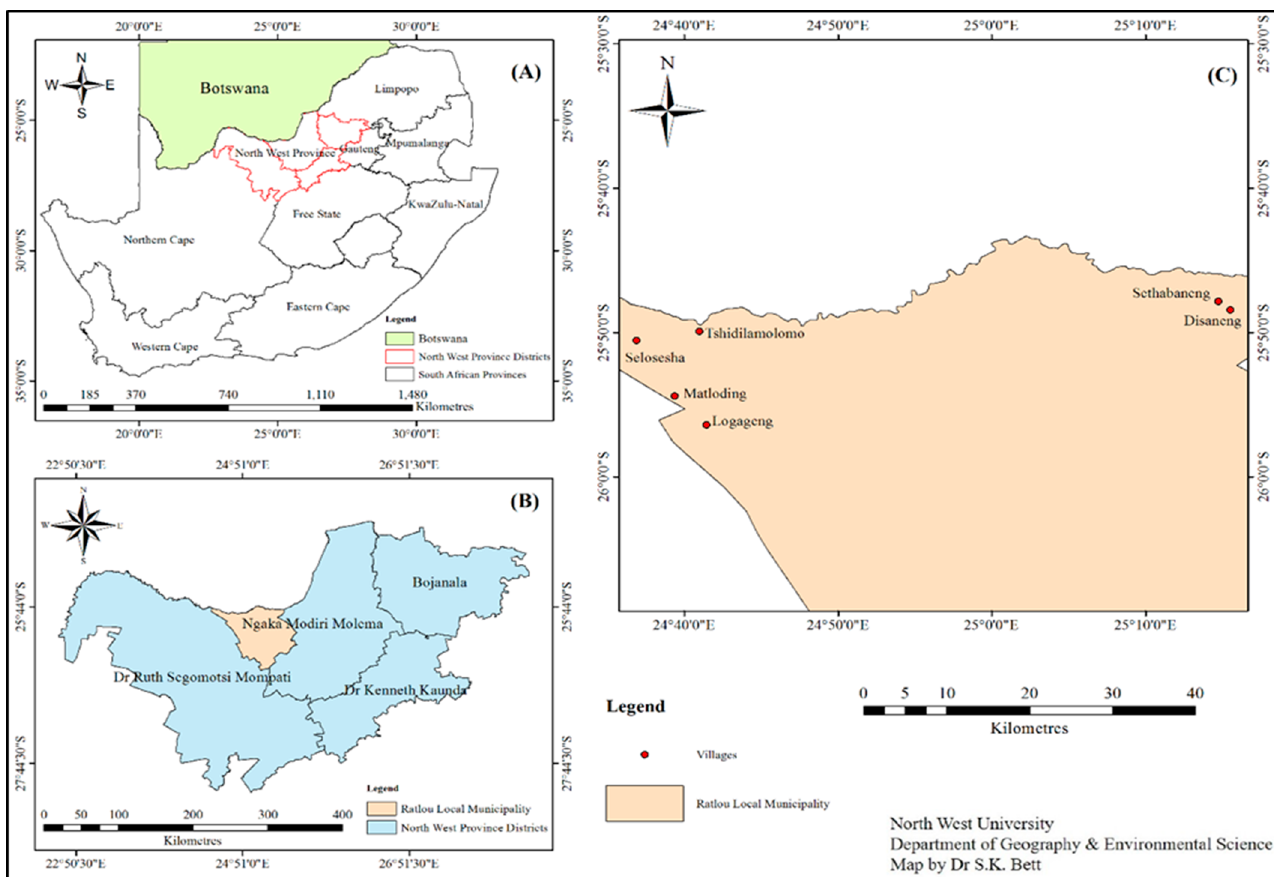
Figure 1. The map shows six selected villages in the Ngaka Modiri Molema District ( C ) in North- West Province ( B ) of South Africa ( A